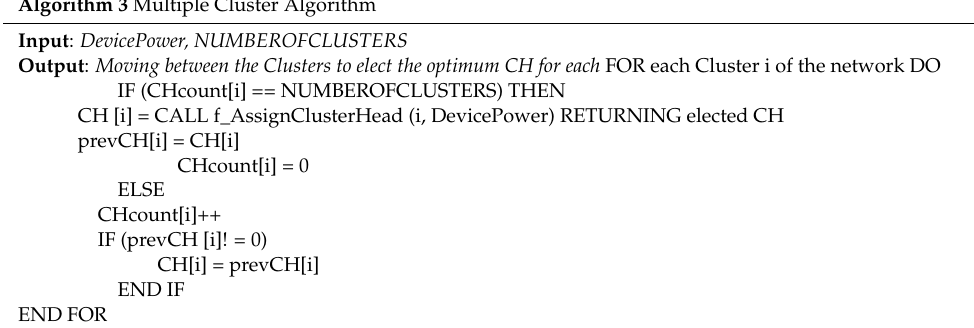
Algorithm 3 Multiple Cluster Algorithm